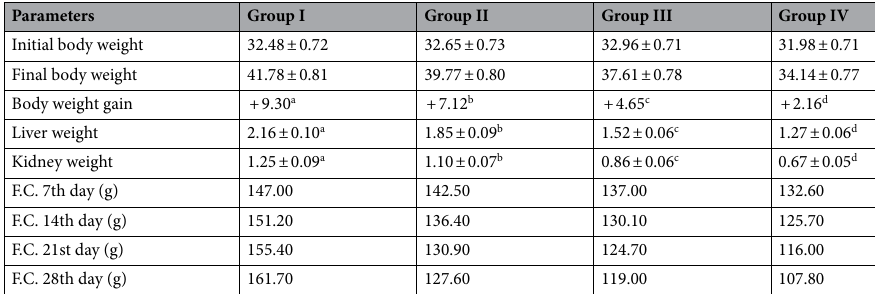
Table 1. Effects of cypermethrin on selected physiological parameters (g). *Group I: control, Group II: 62.5 mg/kg b.w cypermethrin, Group III: 125 mg/kg b.w cypermethrin, Group IV: 250 mg/kg b.w cypermethrin. F.C: feed consumption. For each group, 210 g of feed was put into the cages weekly. Values are shown as mean ± SEM (n = 6). Data were analyzed with SPSS computer program using Duncan test and ANOVA variance analysis. The averages shown with different letters (a–d) on the same line are statistically significant ( p <